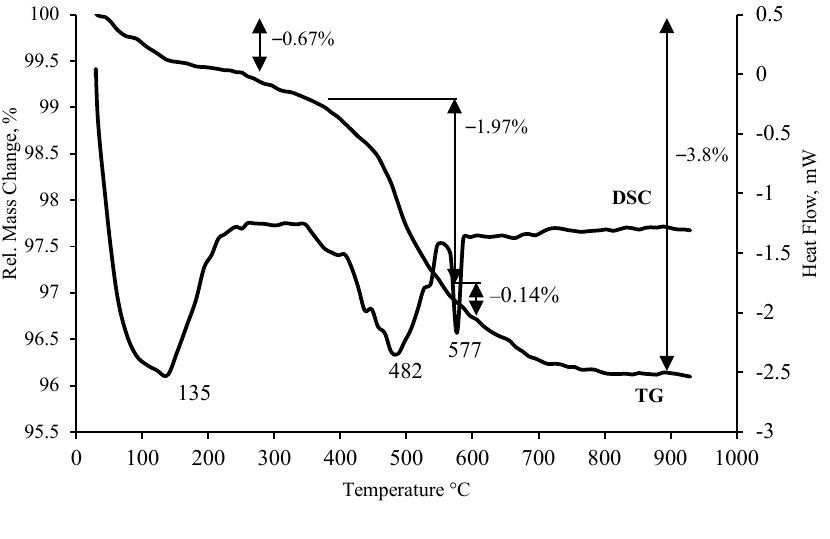
Fig. 4. DTA/TG analysis of raw